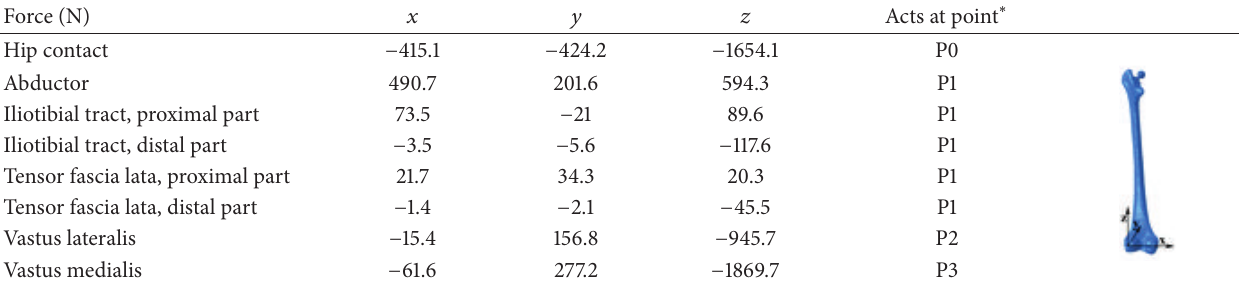
Figure 3: Variation of modulus of elasticity (a) in longitudinal direction from distal to proximal when the radial volume fraction gradient is 0 and (b) in radial direction from external surface to internal core when the longitudinal volume fraction gradient is 0. Table 3: Stairs climbing-frame of maximum torsional moment [32, 33].